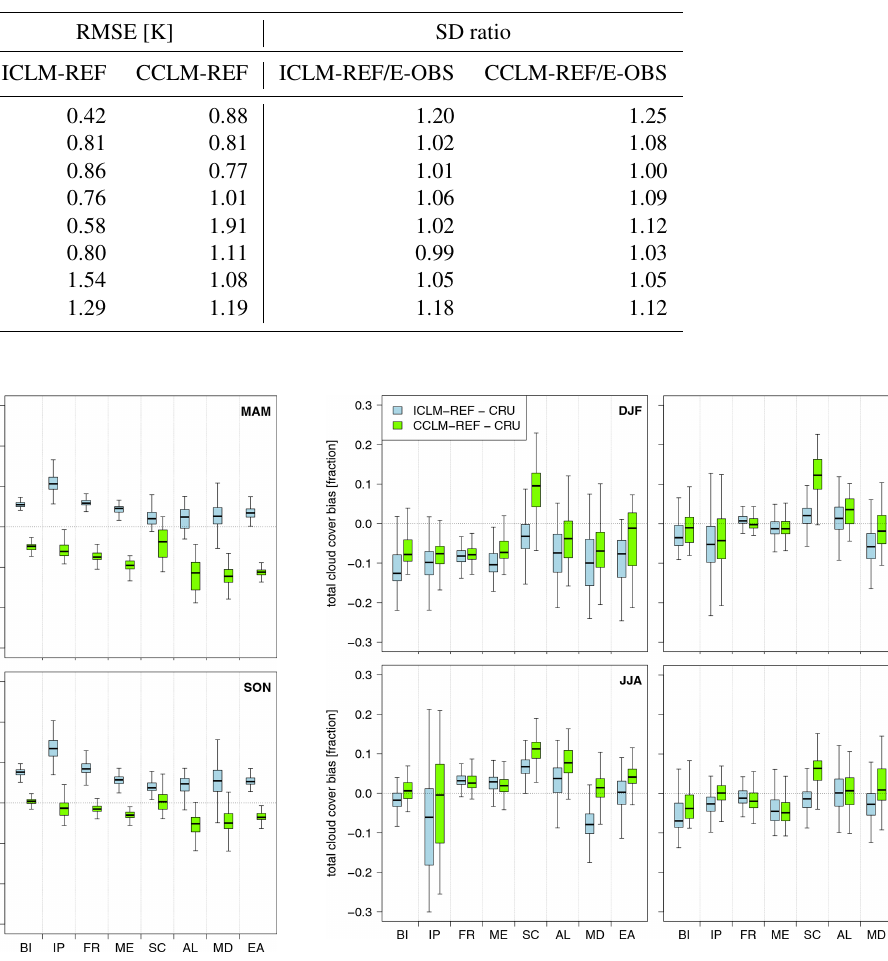
Figure 10. Same as Fig. 5 but for total cloud